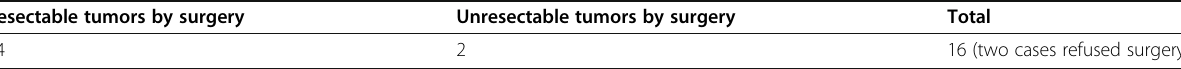
Table 3 Resectability of MDCT correlated with surgical outcome Resectable tumors by surgery